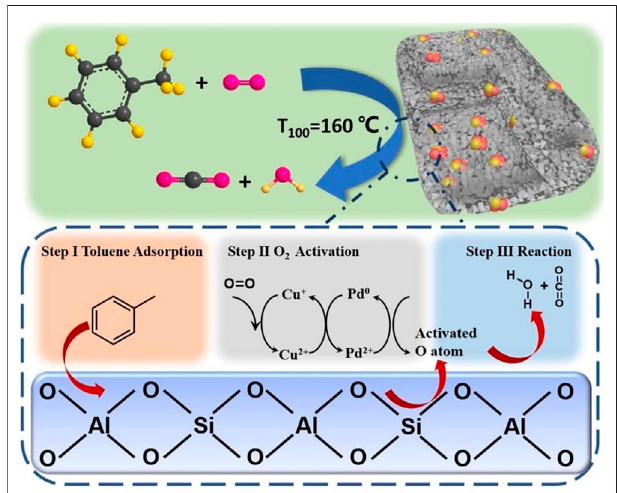
FIGURE 1 | Mechanism of toluene degradation on the surface of PdCu alloy supported on mesoporous ZSM-5 (He et al.,